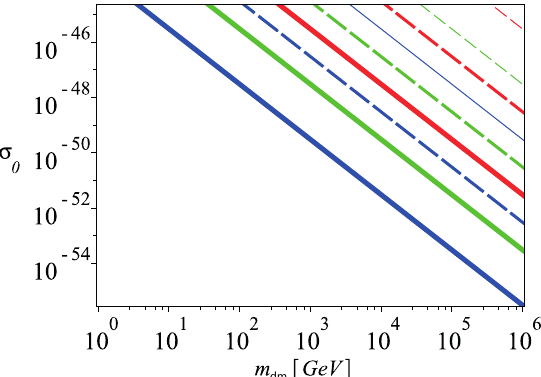
Figure 4. Dark matter nucleon cross section obtained from the collapse of NSs to BHs due to accumulation of DM. The red lines correspond to σ 0 , and m dm , giving rise to a collapse in 10 6 years. The thicker the line the higher the density from bottom (solid lines) to top (short dashed lines)—in decreasing thickness and therefore density: 10 11 , 10 8 , 10 5 . The green lines case giving rise to a collapse in 10 8 years. The blue lines correspond to case of 10 10 years.